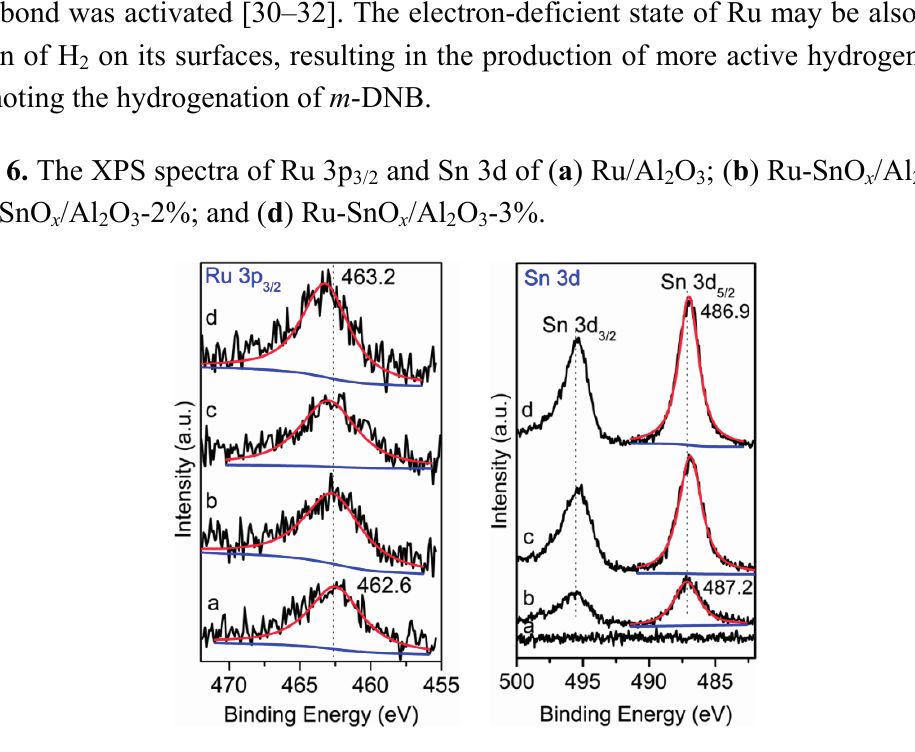
Figure 7. The recycling results of Ru-SnO